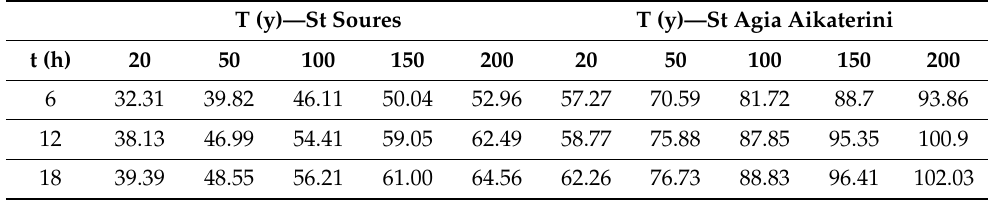
Figure 2. Calculated discharge hydrographs for ( a ) St Soures and ( b ) St Agia Aikaterini. Table 2. Peak flow